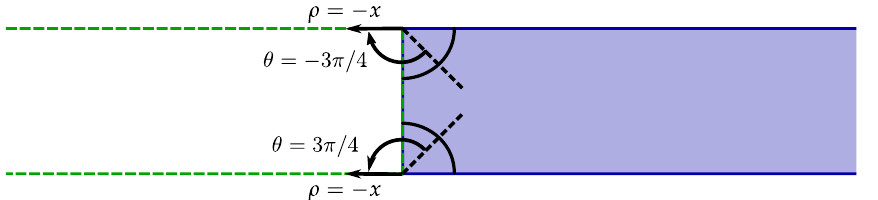
Figure 5. Location of the virtual surfaces in terms of the local corner coordinate system for each corner.